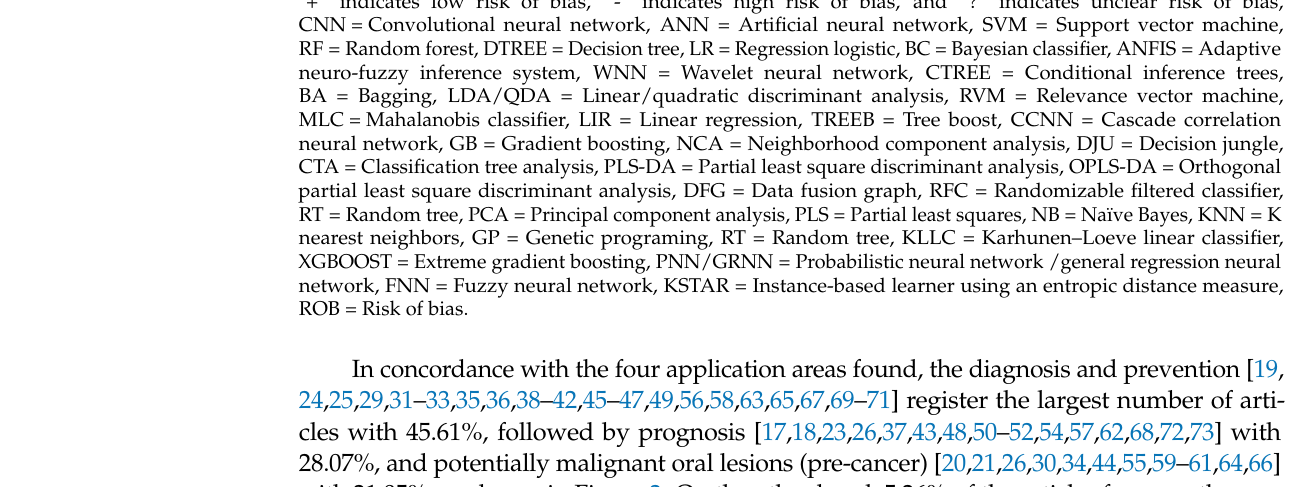
Data-mining model using probabilistic neural network and general regression neural network (PNN/GRNN) for early detection and prevention of oral malignancy